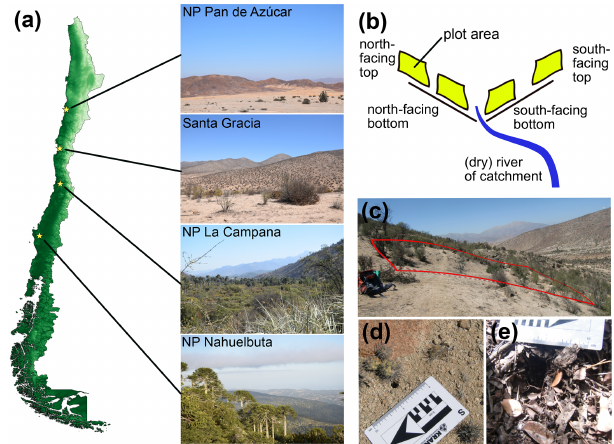
Figure 3. Overview of study sites in Chile. (a) Indication of study site locations (yellow stars) and example images; (b) plot setup on opposing slopes with four plots per study site; (c) example image of plot in Santa Gracia; (d–e) examples of measured burrow entrances ( d : on bare ground, Santa Gracia; e : within leaf litter, NP La Cam- pana); NP – National